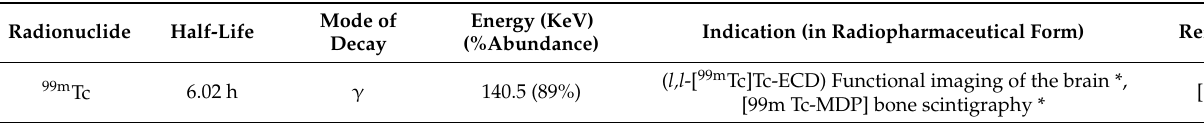
Table 2. Radionuclides for diagnosis